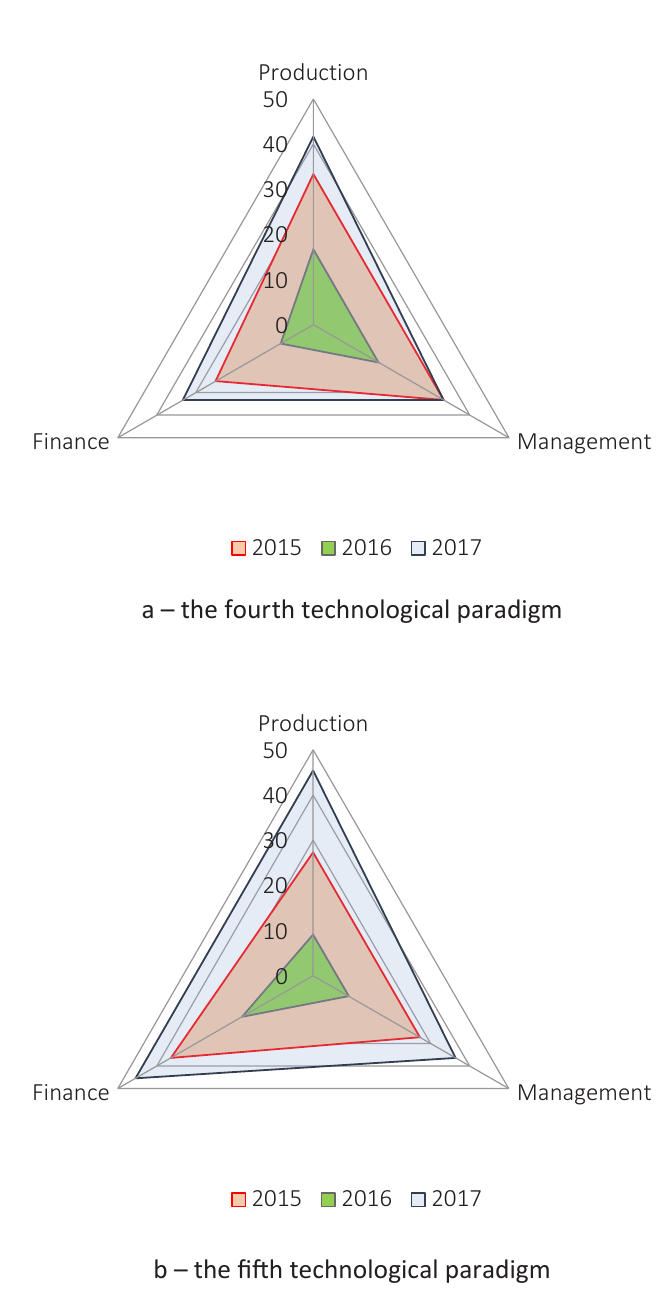
Figure 6. Distribution of machine-building enterprises according to the effectiveness of the projects executed in ensuring the development